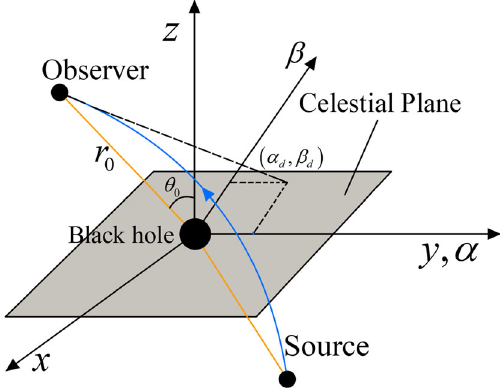
Fig. 1 Schematic diagram of a distant observer’s celestial plane and celestial coordinates